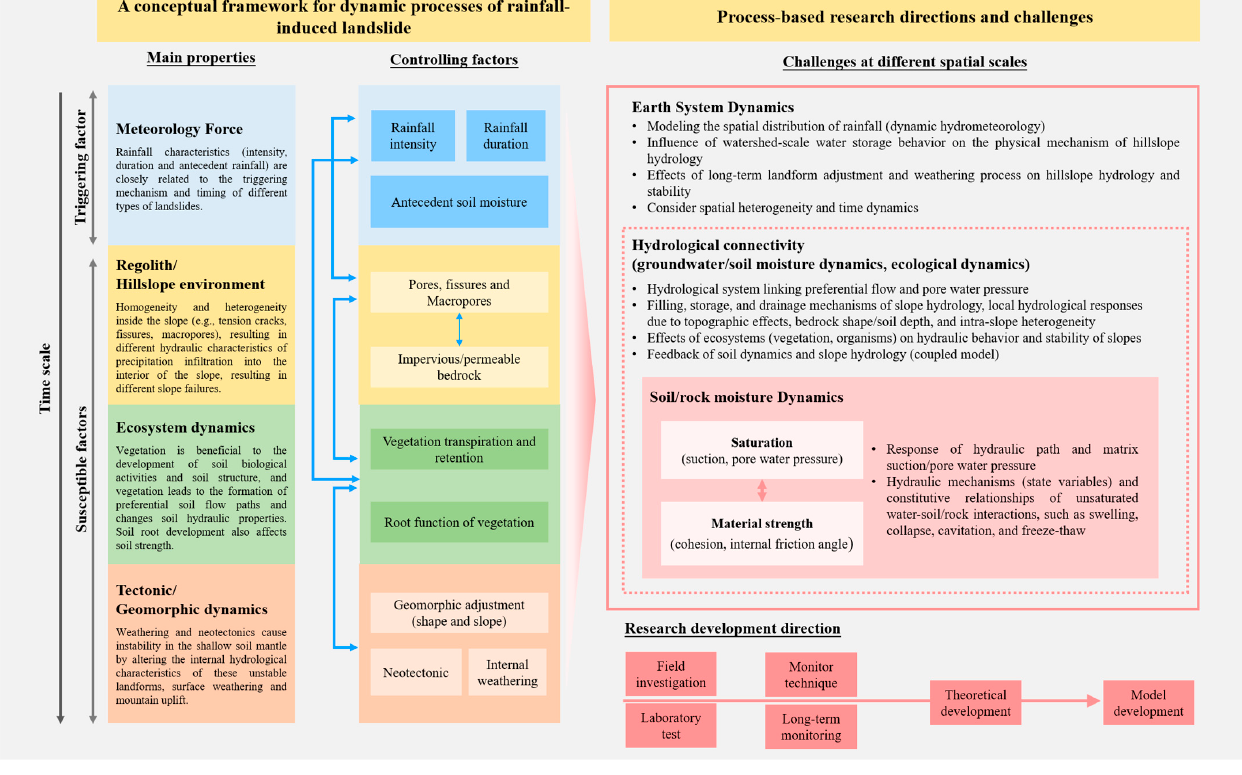
Figure 3. Dynamic processes and research challenges for hillslope hydrology and stability.